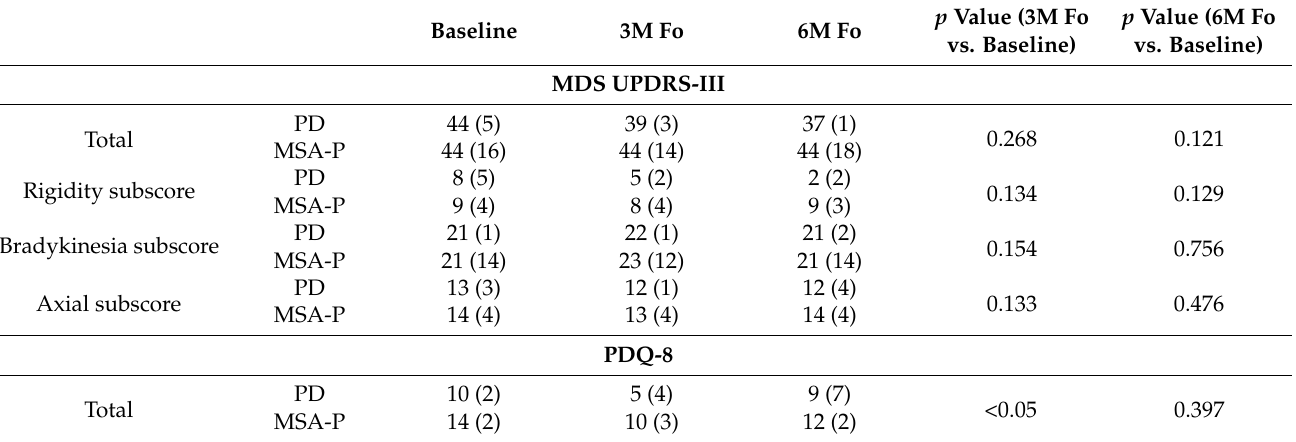
Figure 2. Effects of HCSCS on gait and dysarthria in PD and MSA-P patients at 3-month and 6-month postoperative treatment states when patients were off-medication. Upper left: time to complete TUG task; Upper right: stride length; Bottom left: DSI score; Bottom right: speech intelligence, as measured by the speech item of MDS UPDRS-III. Means are plotted with error bars representing the standard errors of the mean. PD and MSA-P data are plotted separately by hollow circle and solid circle. * p < 0.05 indicates significant difference between conditions. Table 3. Motor symptoms and life of quality.